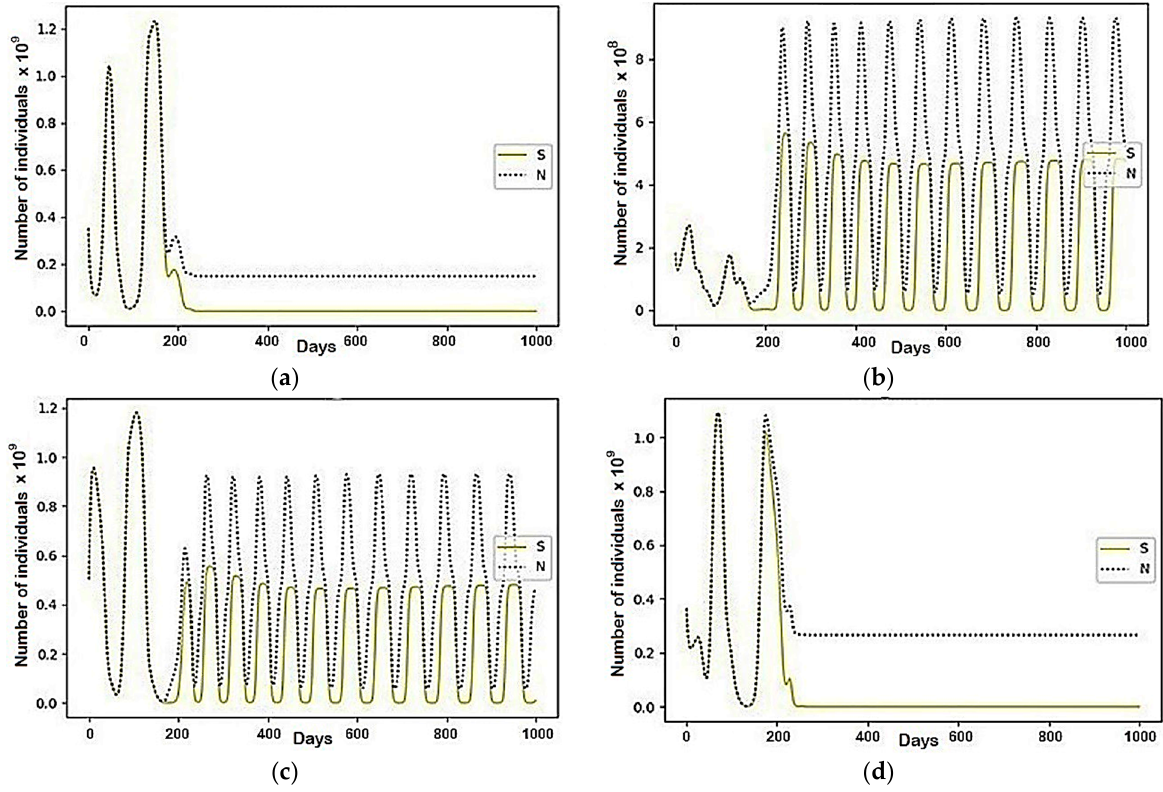
Figure 7. The modeling results describing the total population size (N) and the population be- longing to the susceptible (S) group, where a 1 = 1, b 1 = − 0.1, b 4 = 0.05, c 1 = − 0.15, c 4 = 0.1, d 1 = − 0.3, d 2 = − 0.7, and the rest are equal to zero: ( a ) Region 1; ( b ) Region 2; ( c ) Region 3; ( d ) Region